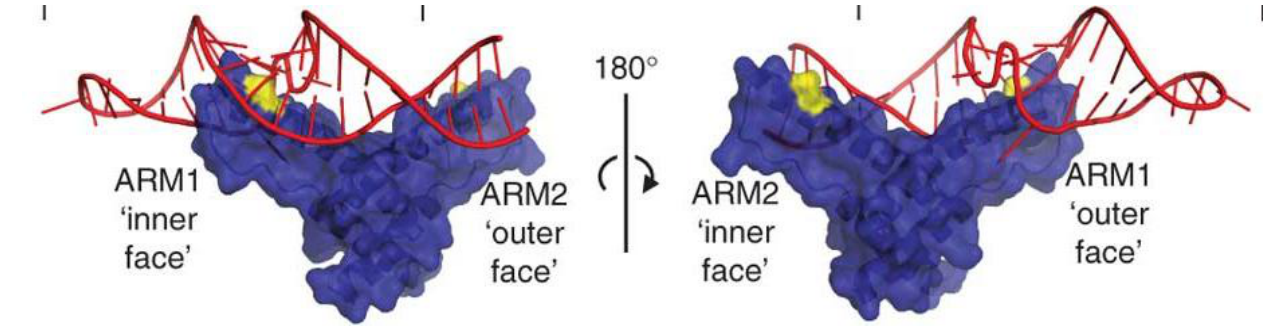
Figure 2. Model of the Rev dimer interacting with a model Rev Response Element (RRE) stem IIB binding site. In this model, the second monomer binds cooperatively using a different surface of the arginine rich helical motif (ARM) to contact the RNA (red). The yellow residue in the diagram represents Asn40 which contacts the RNA on the “inner face” of ARM1 but not ARM2 which uses the “outer face” of the ARM to bind. Reprinted with permission from Macmillan Publishers Ltd: Nature Structural & Molecular Biology 17, 1337–1342 (2010)